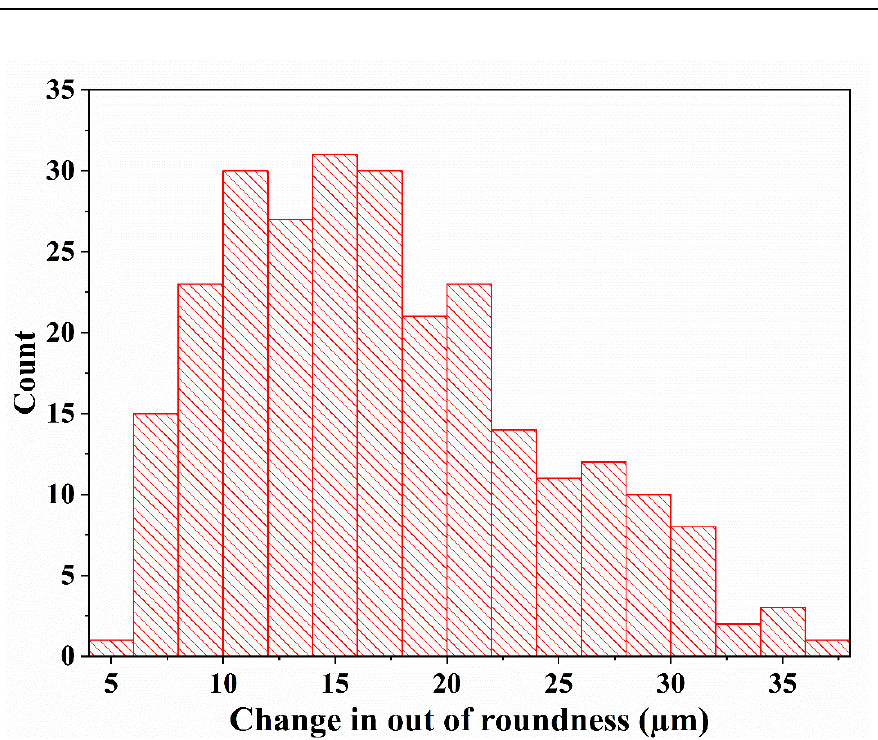
Figure 3. Histogram of the measured change in out-of-roundness (total experiments = 262).